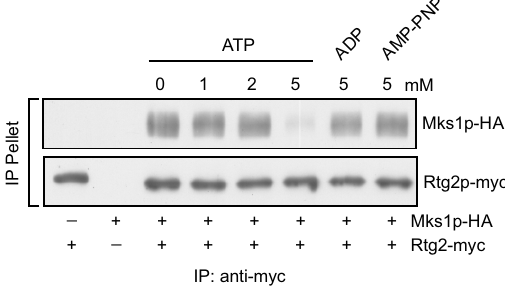
Figure 1. Adenosine triphosphate (ATP) disrupts the interaction between Rtg2 and Mks1 in total cellular lysates. Cellular lysates prepared from yeast cells expressing Rtg2-myc and/or Mks1-HA as indicated were analyzed for the effect of ATP, ADP and (cid:68)(cid:71)(cid:72)(cid:81)(cid:82)(cid:86)(cid:76)(cid:81)(cid:72)(cid:3)(cid:24)(cid:397) - (cid:11)(cid:533)(cid:15)(cid:534) -imido) triphosphate (AMP-PNP) on the interaction between Rtg2 and Mks1